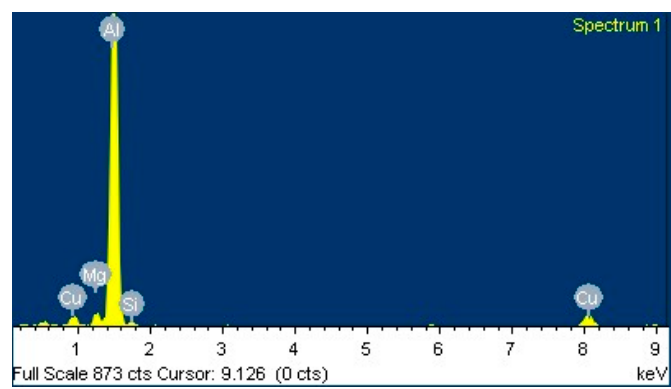
Figure 8. TEM images of as-heated 330 °C samples followed water quenching: ( a ) DU0 alloy and ( b ) DU120 alloy.